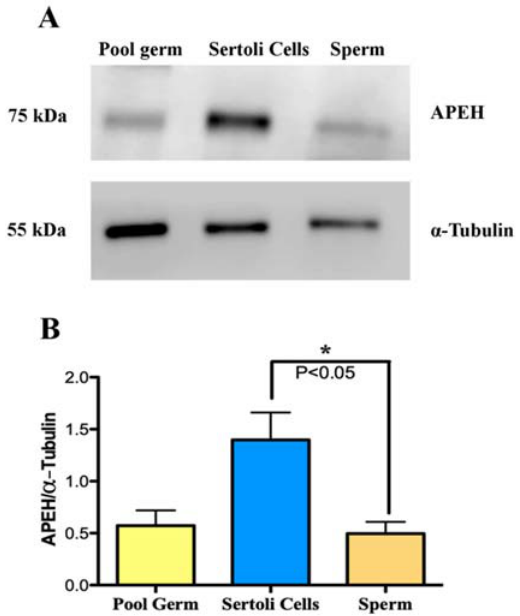
Figure 3. APEH protein levels in isolated cells obtained from male rat reproductive tissues. ( A ) Protein extracts from pooled germ cells, Sertoli cells, and sperm were obtained from primary cultures and epididymal cauda from male rats, respectively. Extracts (30 µ g) were fractionated by SDS-PAGE, transferred to PDVF membranes, and subjected to Western blot using APEH antibody. ( B ) The signal intensity of APEH was quantified with Image J and normalized against the signal intensity of α -Tubulin. Data points represent mean ± SEM of three independent experiments. Significant differences were found with non-parametric one-way ANOVA (* p < 0.05).